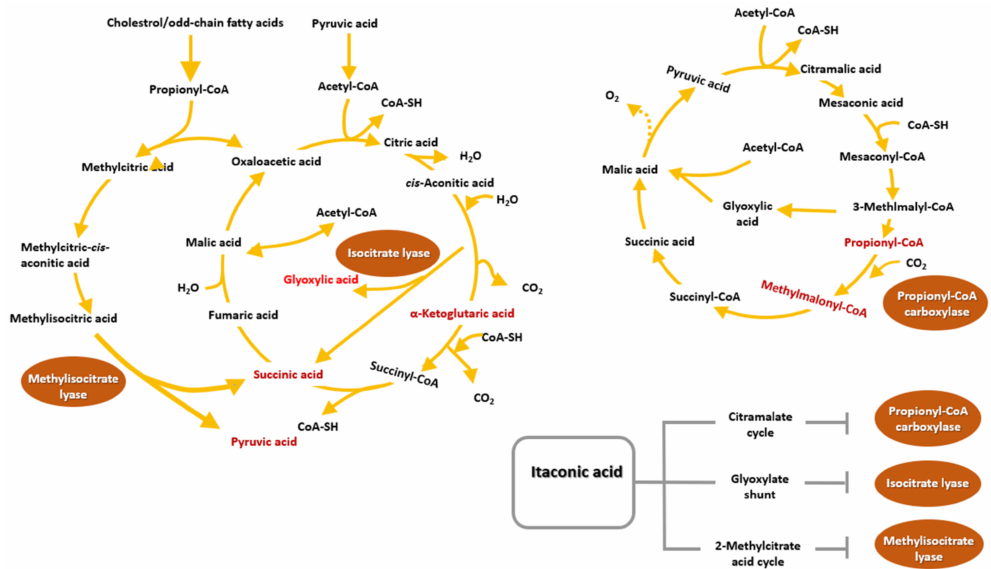
Figure 9. The role of itaconic acid on anti-microbial activities. It inhibits key enzyme isocitrate lyase that has methylisocitrate lyase activity in Mycobacterium tuberculosis. It also inhibits the 2-methyl citrate cycle. The citramalate cycle was halted by inhibition of propionyl-CoA carboxylase in the proteobacterium Rhodospirillum rubrum. Enzymes inhibited by itaconic acid are enclosed in a circle. Reproduced with permission from